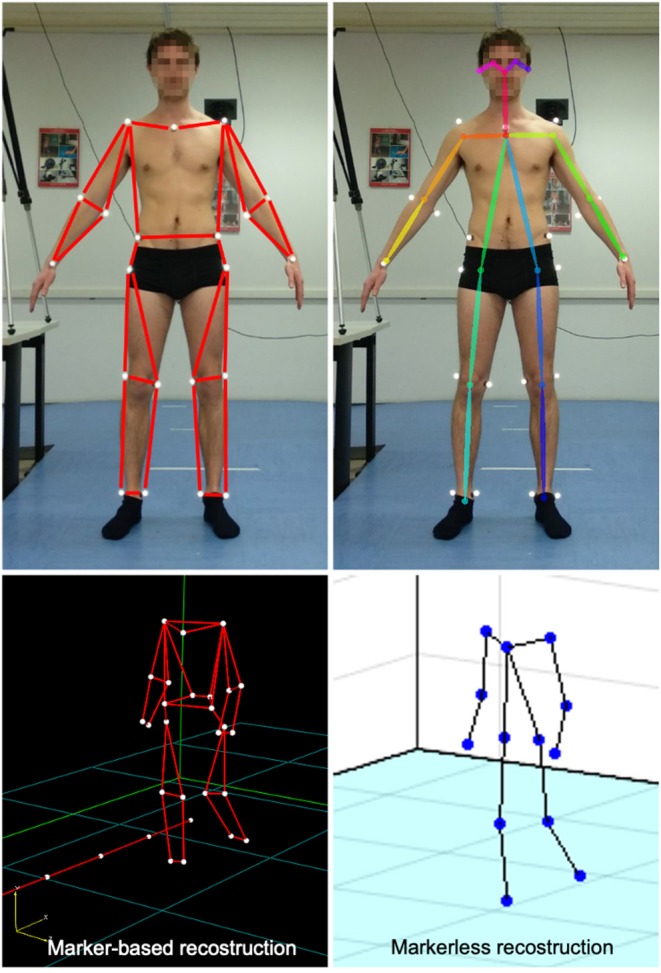
Stick diagrams as returned by the marker-based optical system (top, left) and OpenPose model (top, right); corresponding 3D reconstruction of the skeletal structures during walking (bottom).